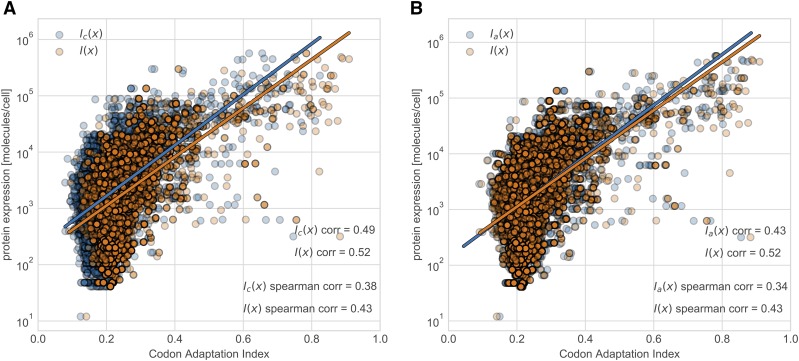
Corrected and original codon adaptation indices vs. protein expression levels for genes containing algorithmically identified -1 PRF signals and with known expression levels (von der Haar 2008), assuming p=0.3 and π=0. A) The original codon adaptation index values of mRNA sequences x of genes from the (von der Haar 2008) data set are shown as orange, semi-transparent points. The shown genes all contain algorithmically identified -1 PRF signals. The shape of the relation between CAI and protein expression is similar to that shown in (Ghaemmaghami et al. 2003) for all genes with known expression levels. Blue, semi-transparent points denote the values of -1 PRF corrected CAI values, Ic^,
vs. same protein expression levels. Regressions between the log10-protein expression levels and both corrected an original CAI values are shown as orange and blue lines, respectively. B) is analogous to A) using the corrected CUB index Ia.